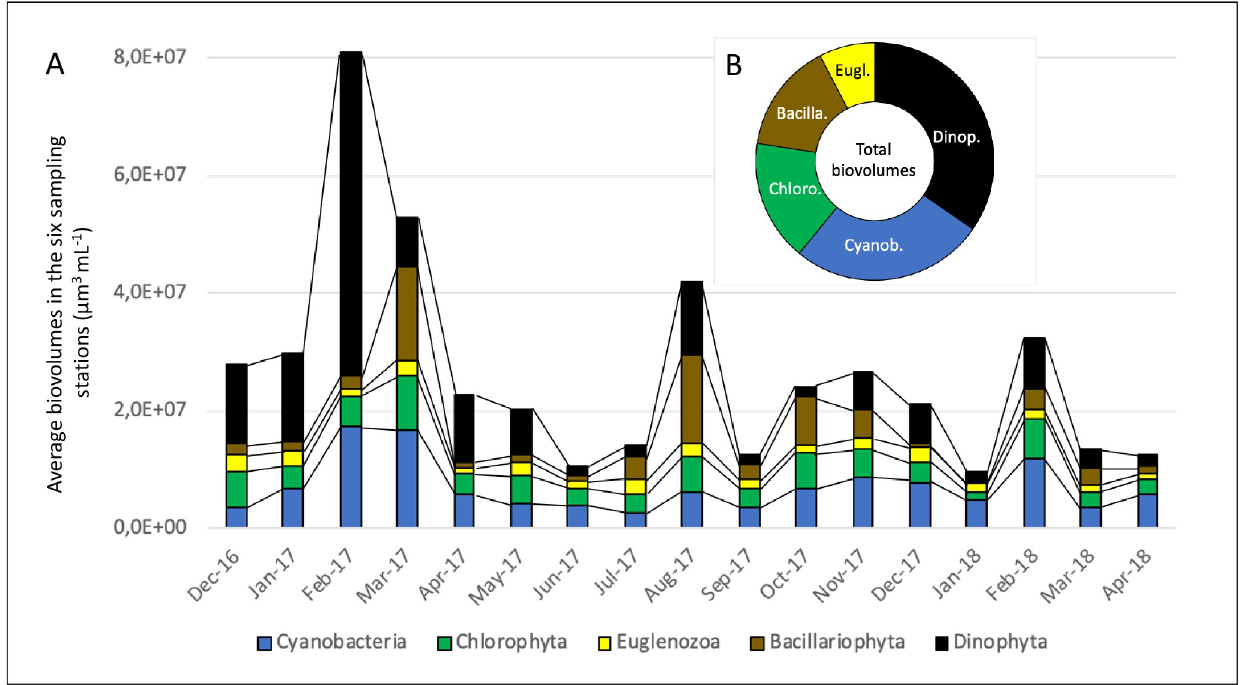
Fig 3. Monthly variations in the average biovolumes of the five main phytoplankton groups during the monitoring of Lagoon Aghien (A) and the average relative contributions of the five main phytoplankton groups to the total phytoplankton biovolume (B).